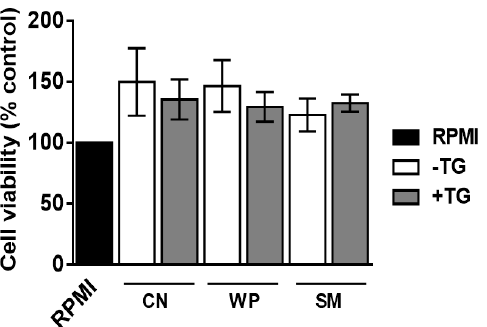
Figure 5. Cytotoxicity assay. The MTT method was used to determine the viability of spleen cells from casein (CN), whey protein (WP), and skim milk (SM) sensitized BALB/c mice cultured with either untreated (white bars) or TG cross-linked CN, WP, and SM (grey bars).